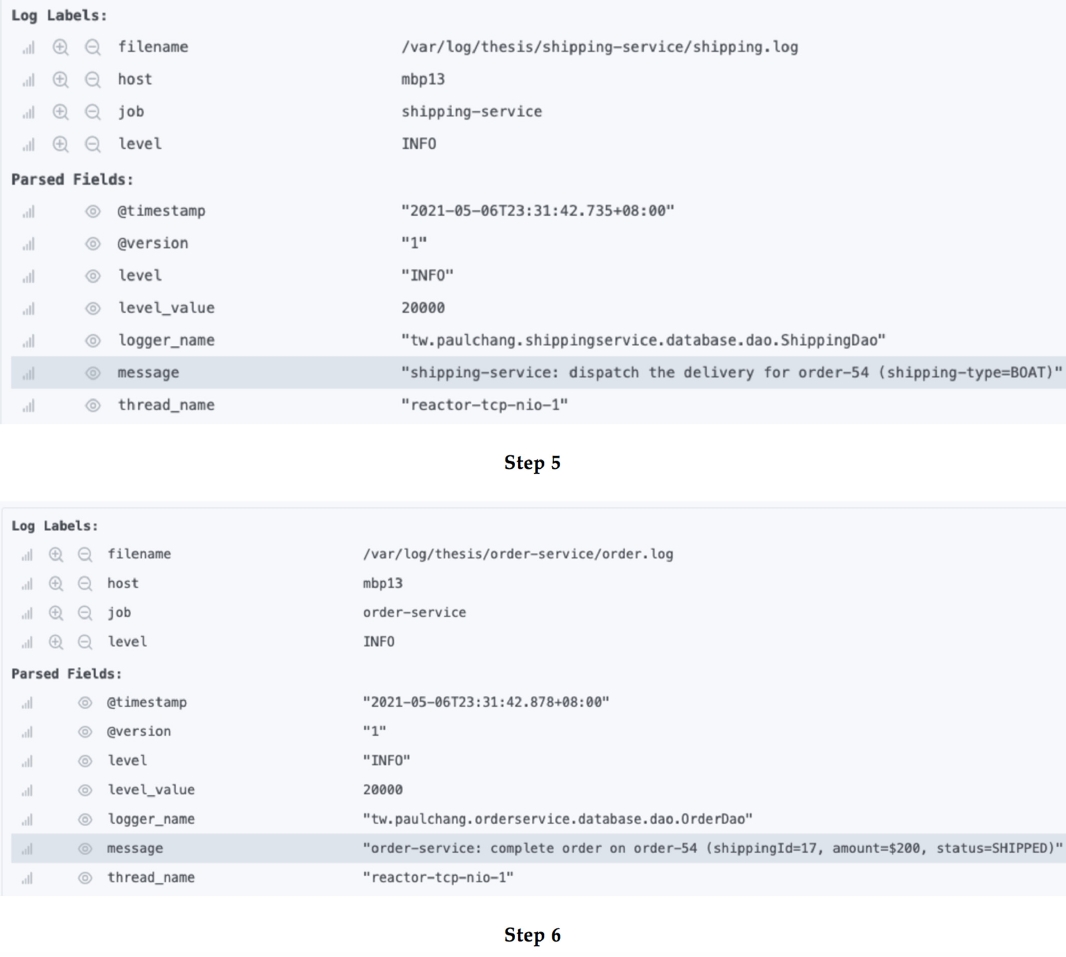
Figure 8. Steps 5, 6 in version 1 (deploying standard saga pattern).